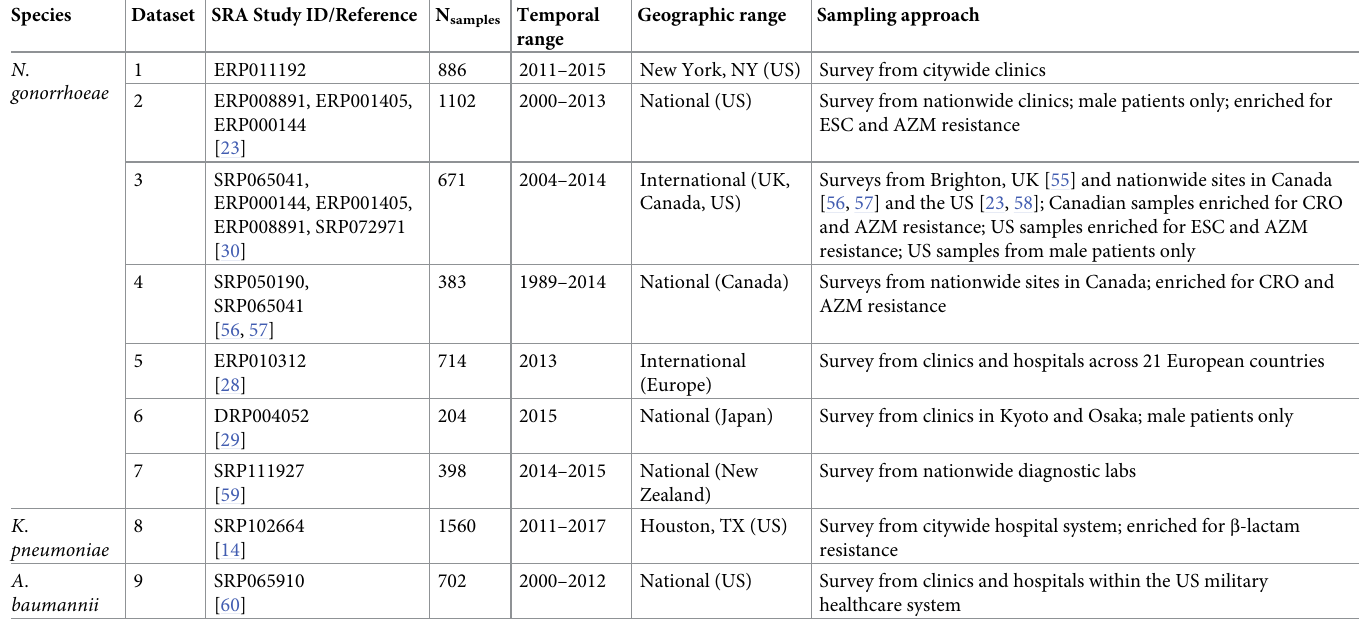
Table 1. Summary of datasets. Dataset SRA Study ID/Reference N samples Temporal